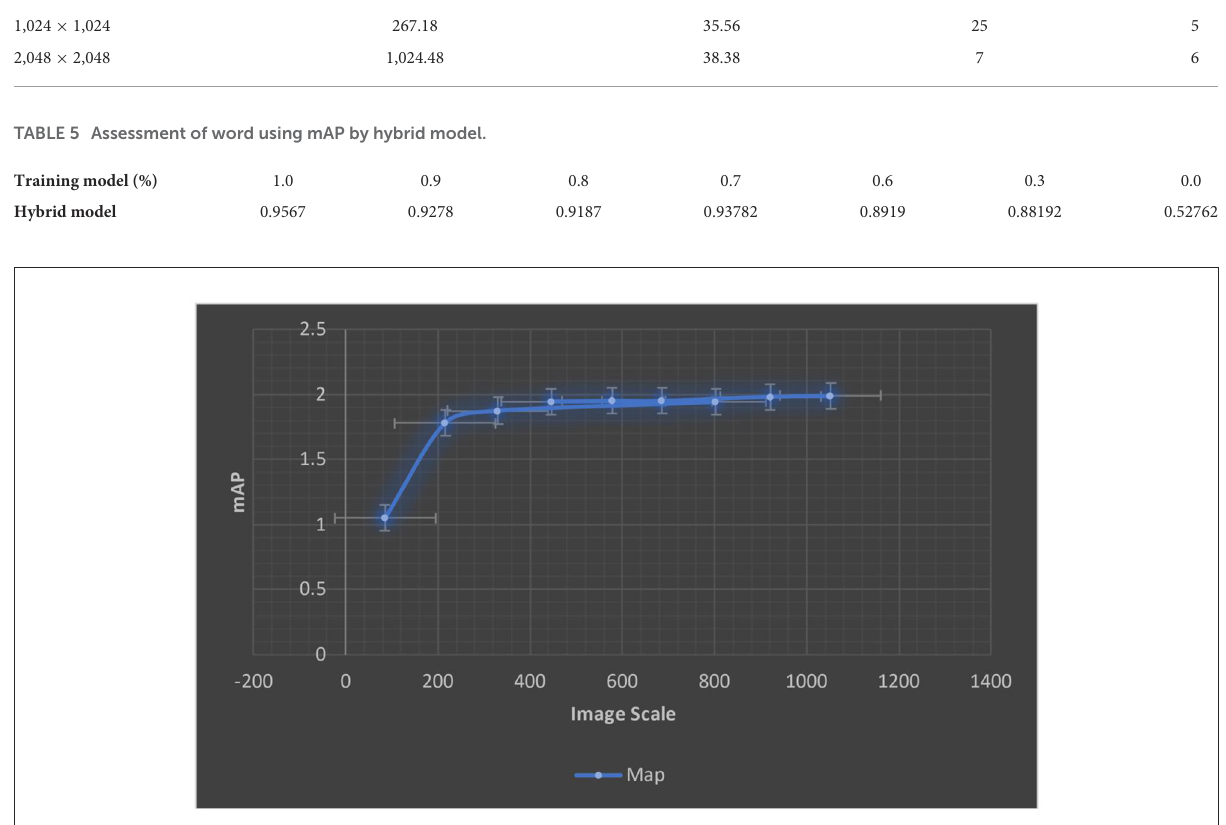
FIGURE13 Performance analysis of learning hybrid model using